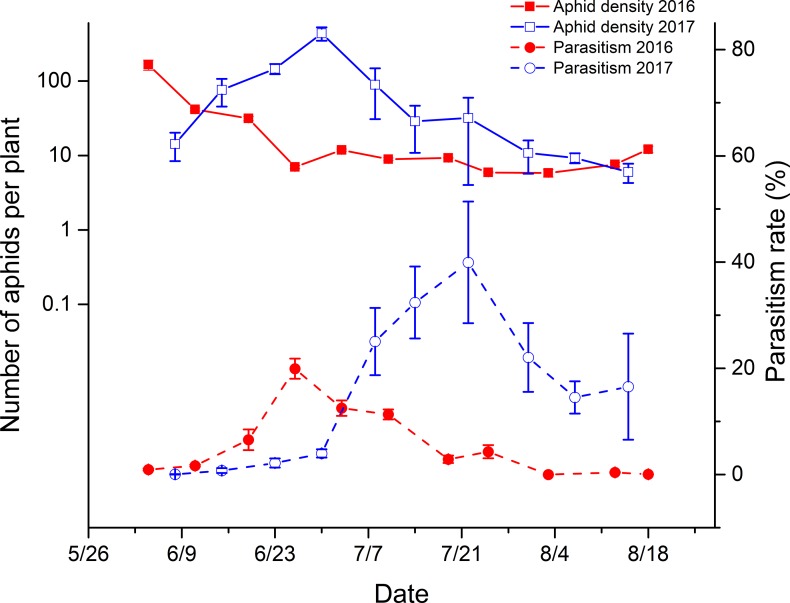
Population dynamics of cotton aphids and their level of parasitism in Aksu, China (2016 and 2017).The data in the figures were shown as the mean ± SE.